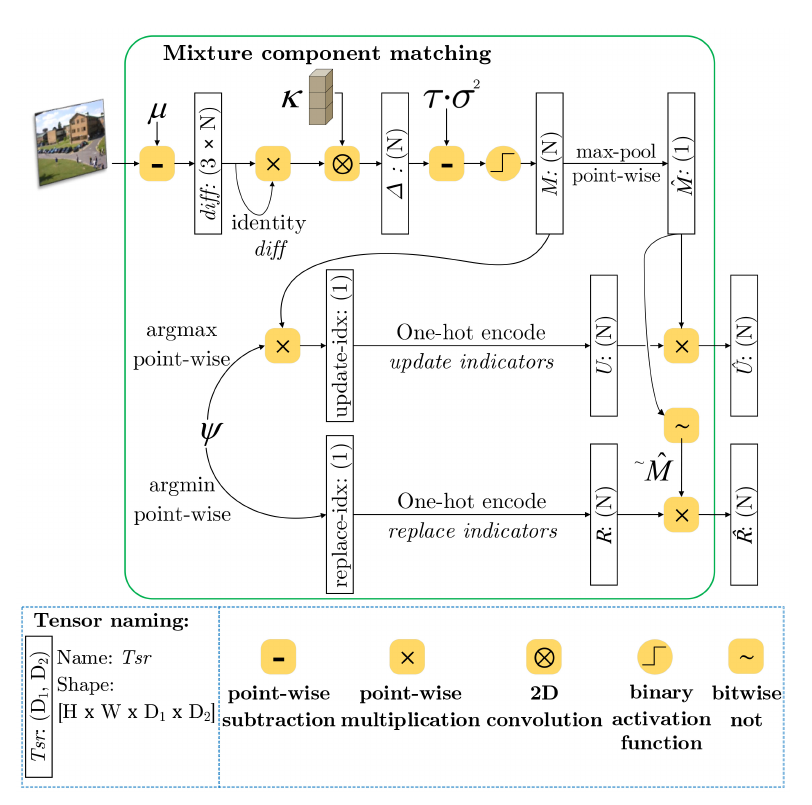
Figure 2. The tensor architecture of mixture component